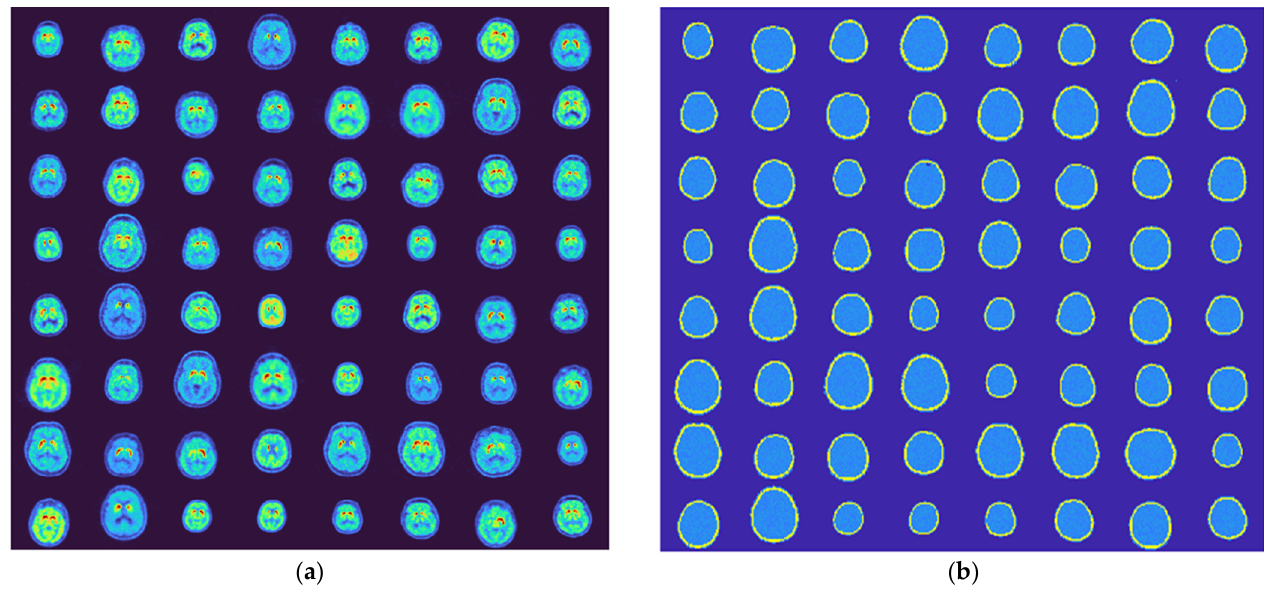
Figure 4. Generated phantoms by the developed generator. ( a ) Generated activity maps and ( b ) generated corresponding attenuation maps. Each sub-image has 128 by 128 pixels.